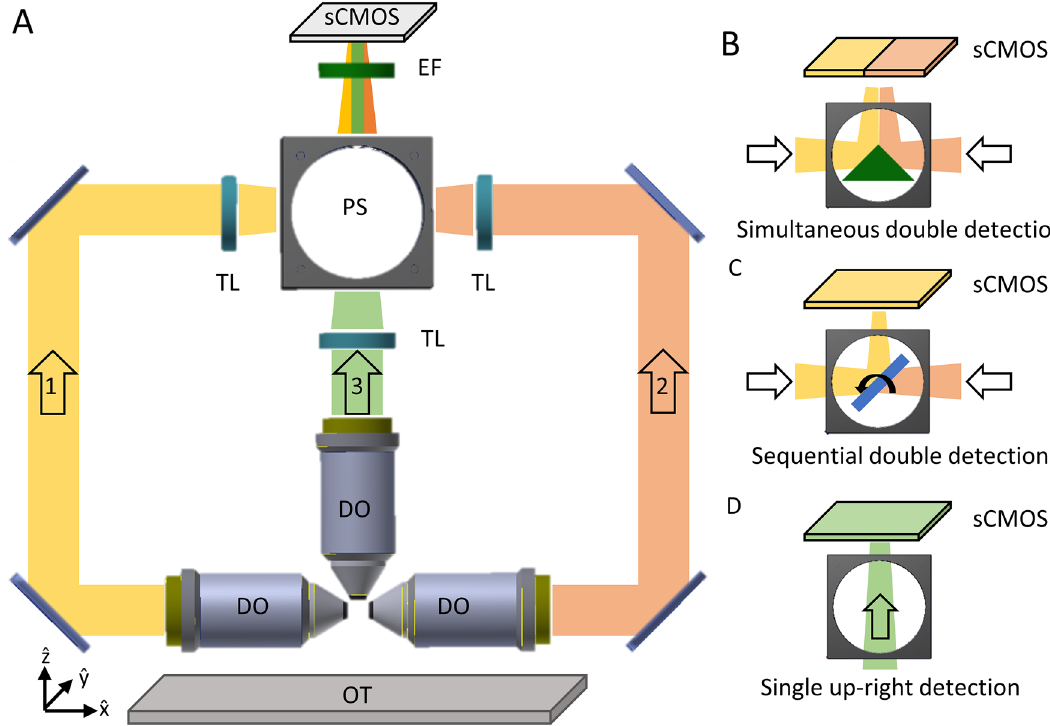
Figure 1. ( A ) Detection scheme enabling the collection of emitted photons through three different paths. DO detection objective, TL tube lens, PS path selector, EF emission filter. The coordinate system is indicated respect to the horizontal optical table (OT). ( B – D ) The elements included in the PS are switchable and permits obtaining ( B ) simultaneous double, ( C ) sequential double, or ( D ) single detection schemes. All optical paths converge after the path selector to reach the sCMOS camera chip. The FoV determined by the camera chip can be either optically split (B) between the views, or used as a full ( C , D ). Figure created with Autodesk Inventor Professional 2015 (www. autod esk.